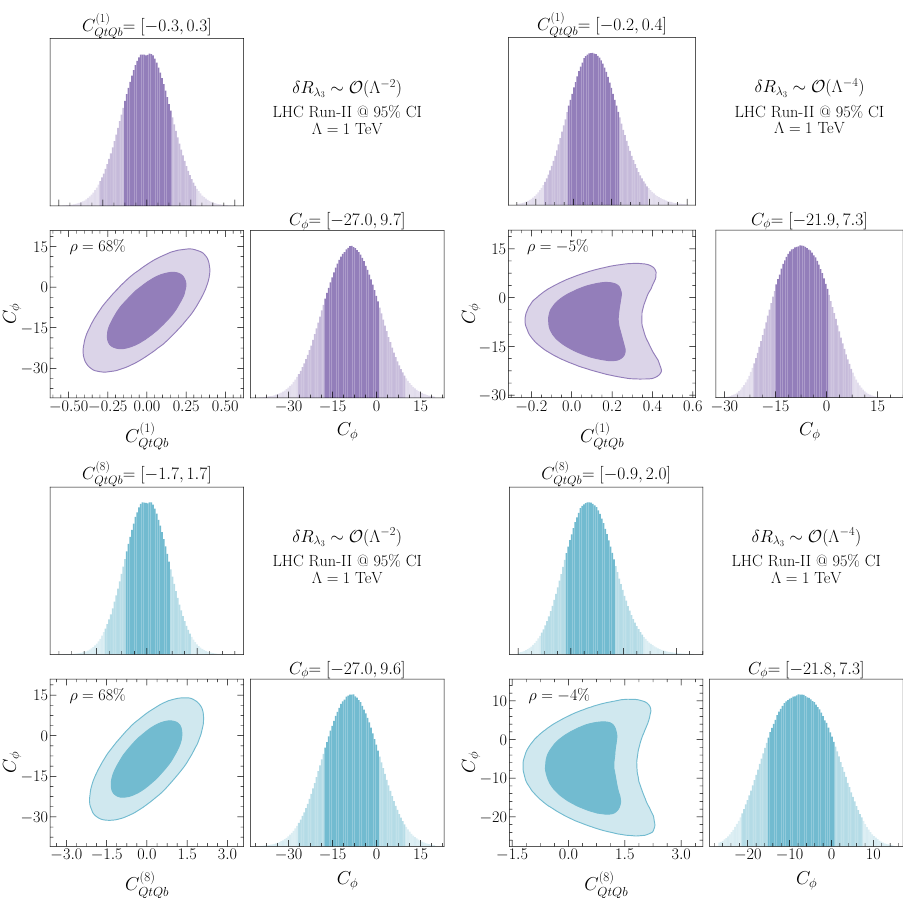
Figure 11 . The 68% and 95% highest density posterior contours of the posterior distribution from the fits of C φ with C (1) (top panels) and C φ with C (8) (bottom panels). We also show QtQb QtQb the marginalised one-dimensional posteriors for each of the Wilson coefficients, with their 68% and 95% HDPIs and, on top of the corresponding figures, the numerical 95% CI bounds. The limits correspond to values of the Wilson coefficients evaluated at the scale Λ = 1 TeV. Similar to figure 10, the left plots shows the results including only O (1 / Λ 2 ) effects in δR λ , while the right 3 ones include up to quadratic terms in the trilinear Higgs self-coupling modification. Due to the degeneracy between the Wilson coefficients C (1) , (8) , the posterior contours and their marginalised QtQb intervals look very similar for both of them (except for the range they